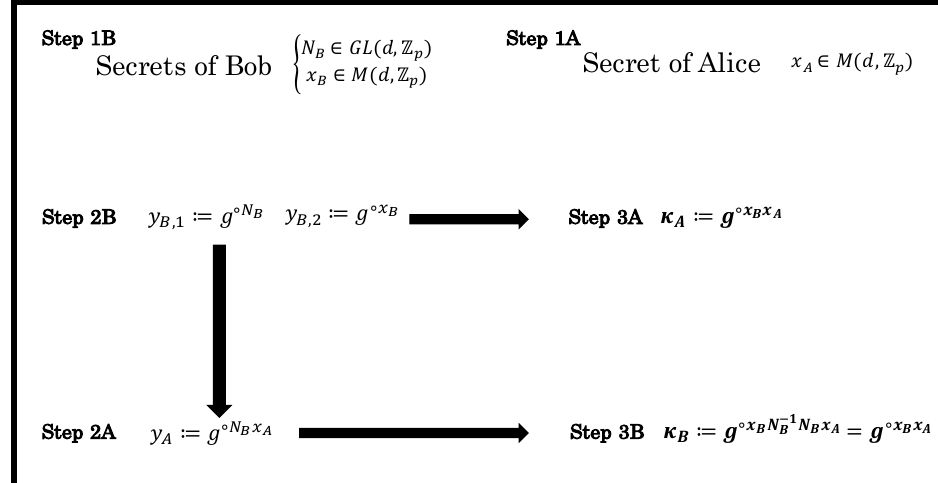
Figure 2. Key agreement process of Schur exponentiation-based